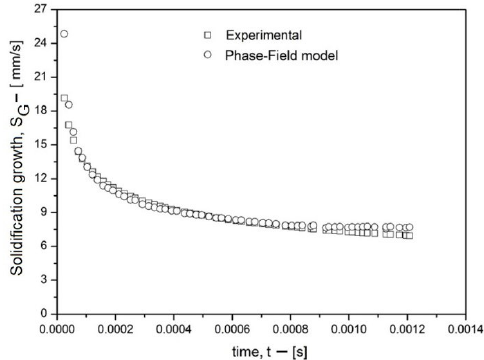
) versus cooling rate ( Ṫ ). 3